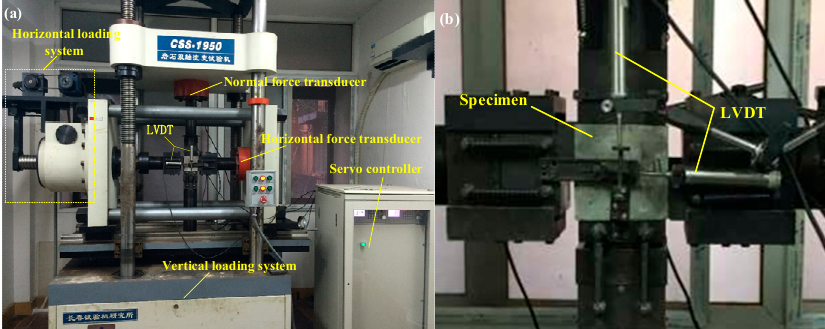
Figure 1. ( a ) CSS-1950 rock biaxial rheological testing machine; ( b ) specimen and monitoring system.